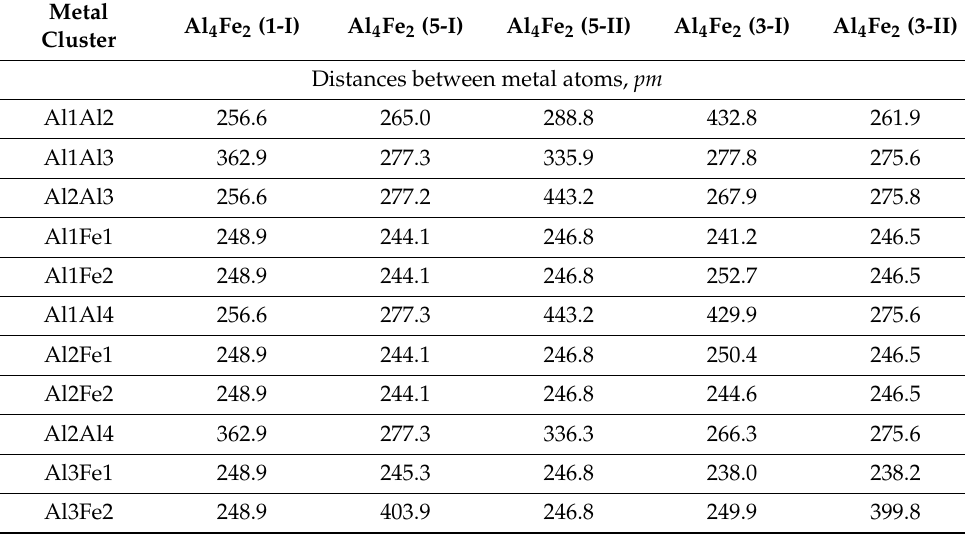
Table 4. Key structural parameters of the most stable Al 4 Fe 2 metal